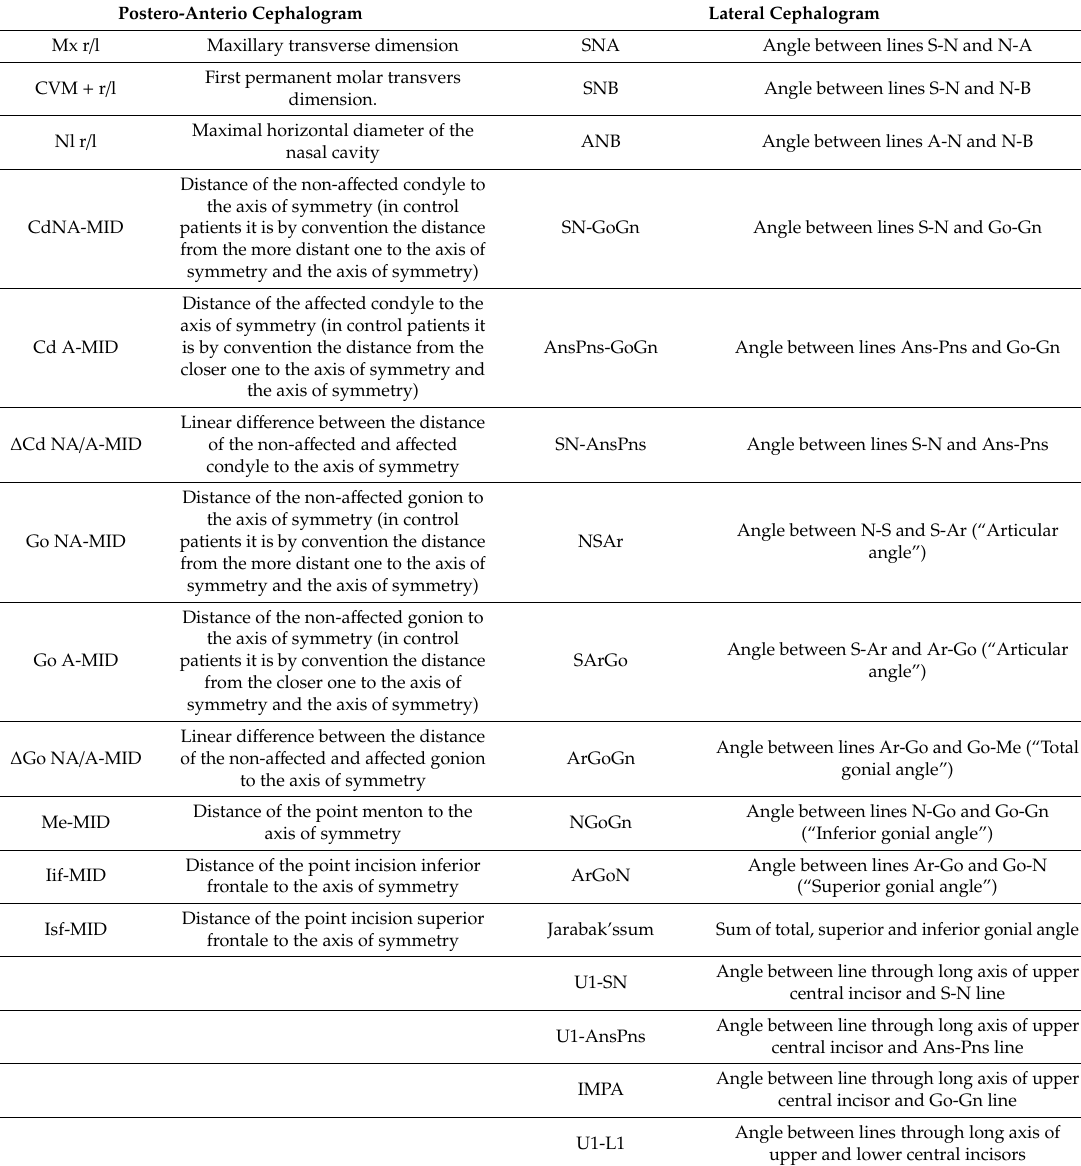
Table 1. Definition of the measurements performed in the present study